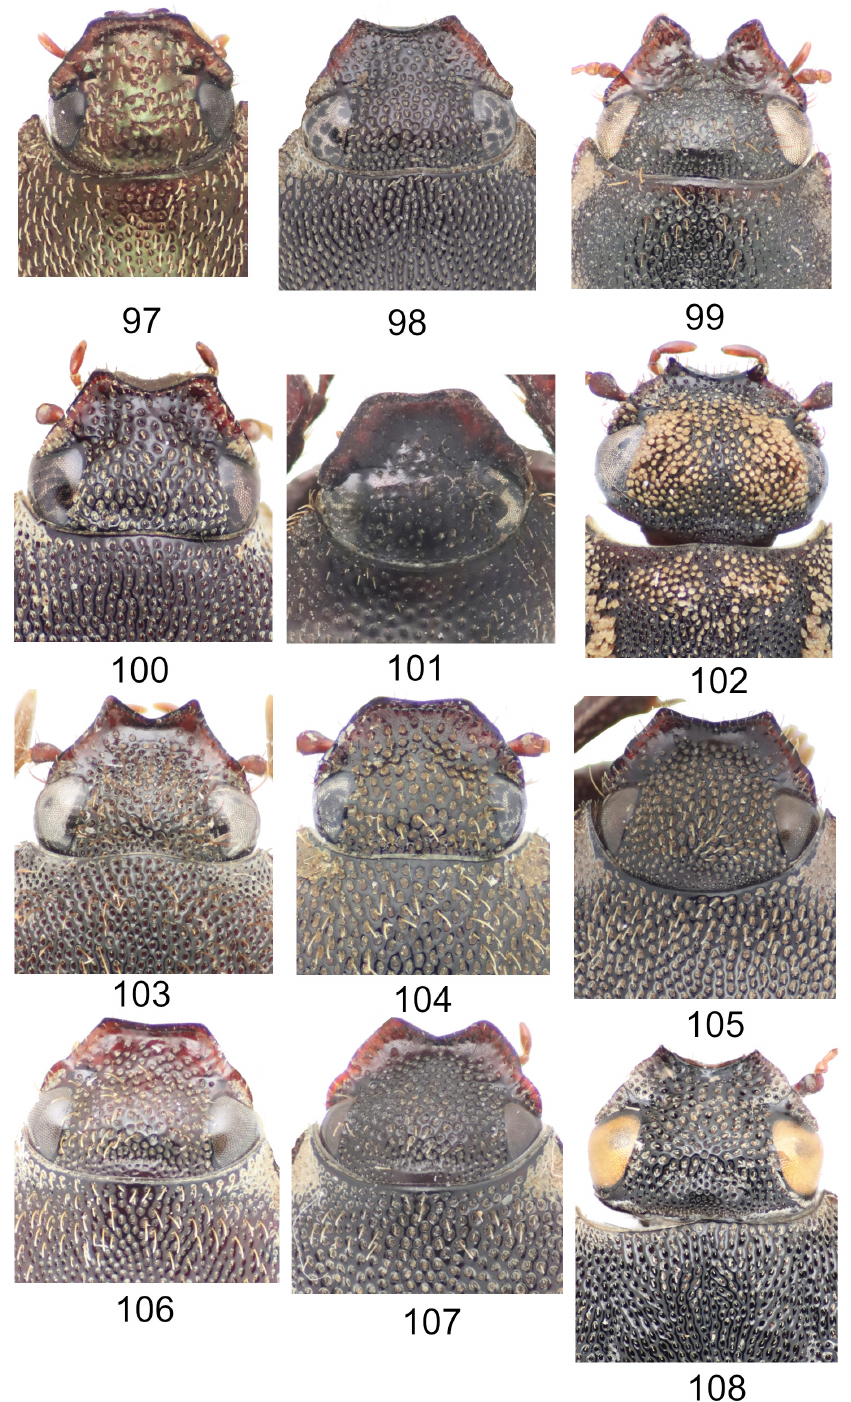
Figs 97–108. Papuan and Wallacean Maechidius Macleay, 1819, head, dorsal view. 97 . M. aenescens Heller, 1910, lectotype, ♀ (SNSD). 98 . M. aiyura sp. nov., holotype, ♂ (BMNH). 99 . M. alesbezdeki sp. nov., holotype, ♂ (NME). 100 . M. angusticeps Arrow, 1941, holotype, ♂ (BMNH). 101 . M. aroae Heller, 1914, lectotype, ♀ (SNSD). 102 . M. bintang sp. nov., holotype, ♂ (NME). 103 . M. awu sp. nov., holotype, ♂ (IECA). 104 . Same, paratype, ♀ (IECA). 105 . M. boessnecki sp. nov., holotype, ♂ (SNSD). 106 . M. babyrousa sp. nov., holotype, ♂ (BMNH). 107 . Same, paratype, ♀ (BMNH). 108 . M. caperatus sp. nov., holotype, ♂ (NME). Not to